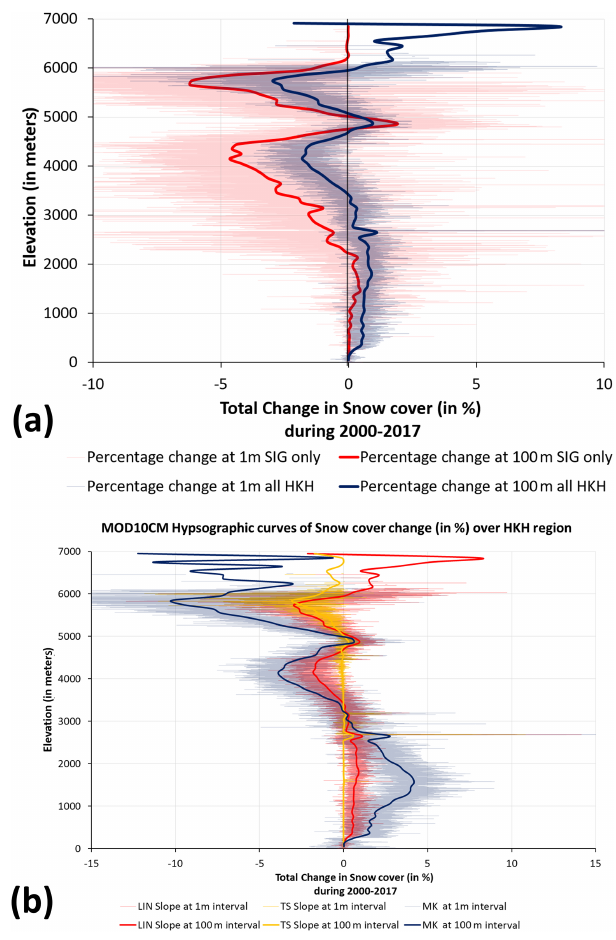
Figure 6. The altitude-wise trend analysis (hypsographic curves) for the (a) snow cover change (in percent) derived from the linear fit (Pearson product–moment correlation; LIN) over the entire HKH region (black curve) and statistically significant trend regions only (red curve). (b) The linear fit model (red curve) over the HKH re- gion (LIN) is compared with the median trend (Theil–Sen – TS) and the monotonic trend (Mann–Kendall statistics, MK; z score) analy-